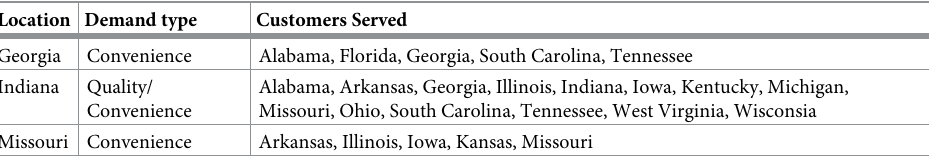
Table 4. Location scheme of the new entrant ( γ 1 = 0.4, γ 2 = 0.6).